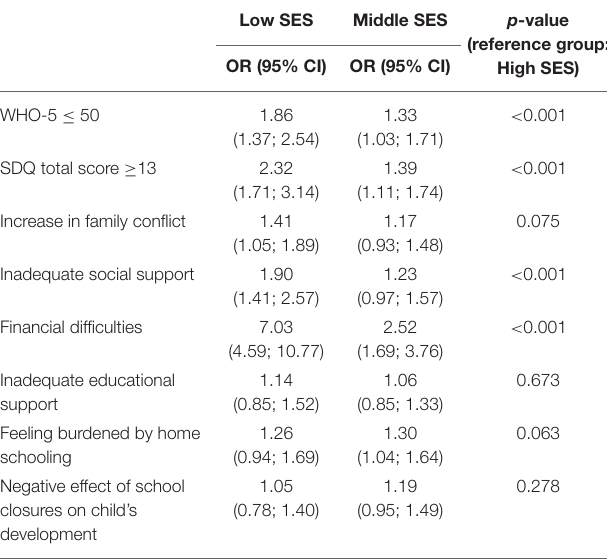
TABLE 3 | Stratified analysis of psychosocial outcomes and perceived burden by socioeconomic status ( N = 1619).